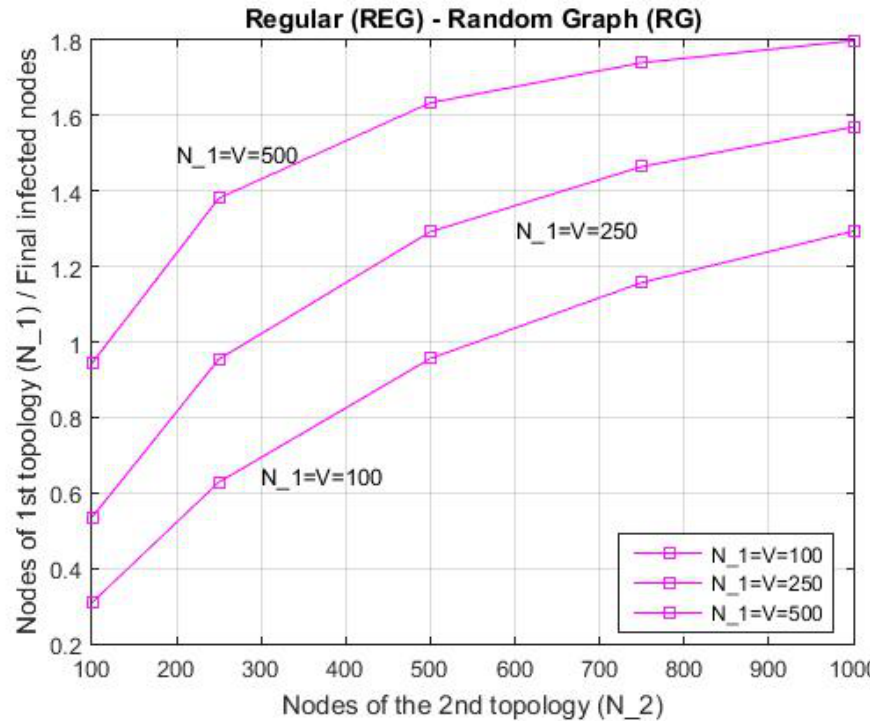
Figure 6. Regular and Random Graph, while N_1 = 100, N_1 = 250 and N_1 =